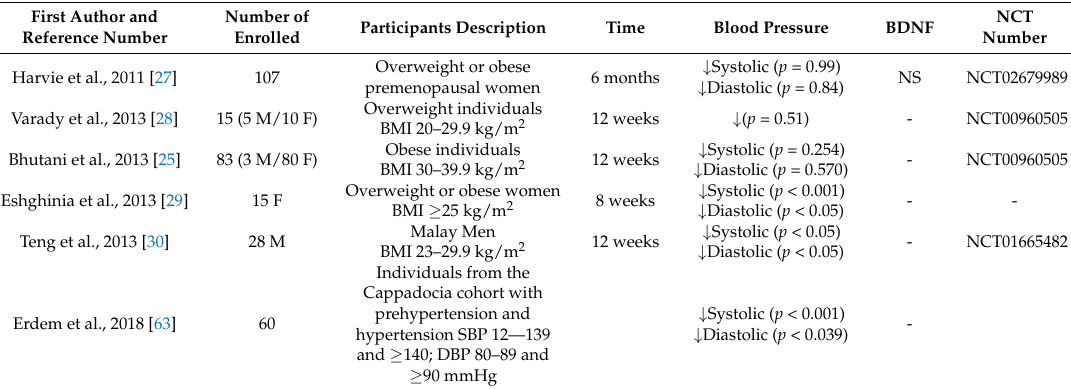
Table 4. Impact of intermittent fasting on blood